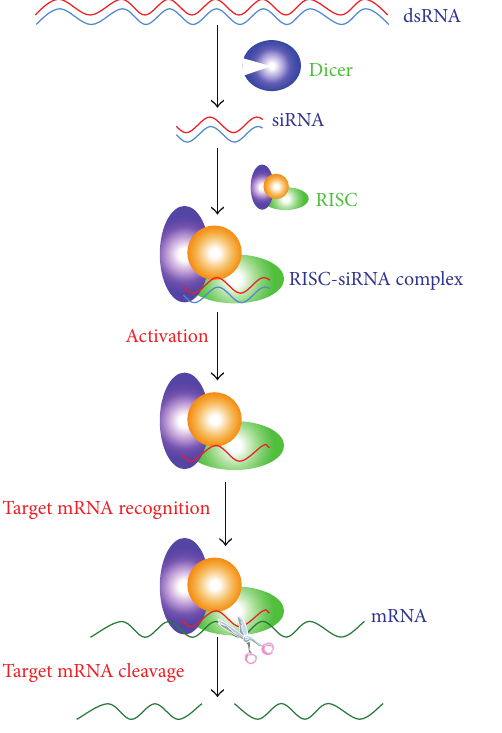
Figure 1: The mechanism of RNA interference. For details see the context and related